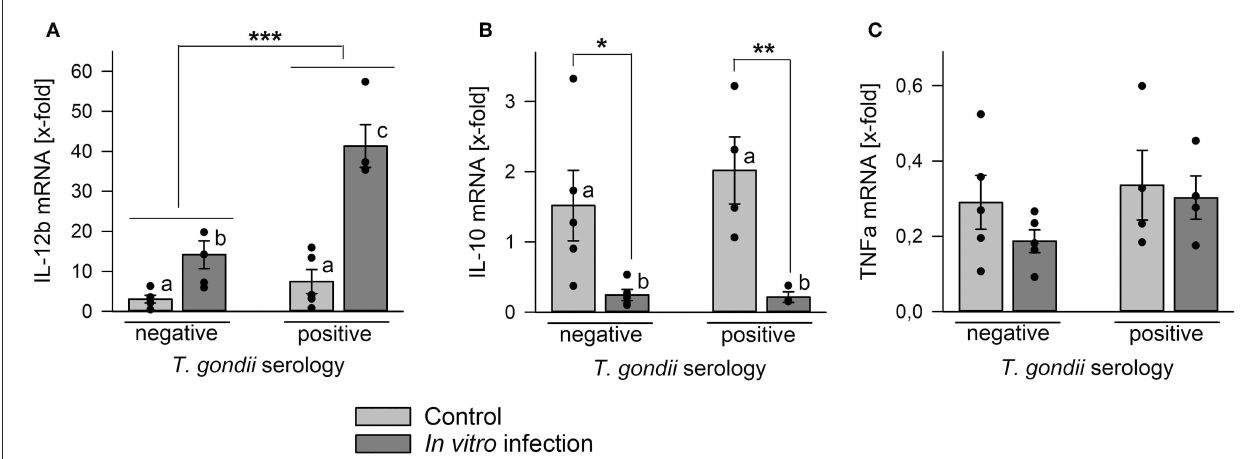
FIGURE 5 | Regulation of mRNA levels of IL-12b, IL-10, and TNFa in monocyte-enriched PBMCs from blood donors with or without chronic toxoplasmosis after in vitro infection with T. gondii . Monocyte-enriched PBMCs were isolated from blood samples and blood donors were serologically classified as chronically T. gondii -infected or non-infected using blood plasma. Cells were either directly extracted for RNA isolation or they were cultivated for 48h and parasite-infected (dark gray bars) or not (light gray bars) during the final 24h. After RNA isolation, mRNA was reverse transcribed and cDNA amplified by quantitative real-time PCR using primer pairs specific to IL-12b (A) , IL-10 (B) , TNFa (C) , and ß-actin. Cytokine mRNA levels were normalized to ß-actin mRNA, and the regulation was calculated between cells directly isolated after blood donation and those after in vitro infection with T. gondii (dark gray bars) or after control cultivation (light gray bars). Bars represent means ± S.E.M. from 5 T. gondii seropositive and seronegative blood donors each; outlyers were excluded. Individual data points are also indicated. Significant differences between groups were identified by ANOVA (*** p < 0.001; ** p < 0.01; * p < 0.05); bars labeled with different letters differ